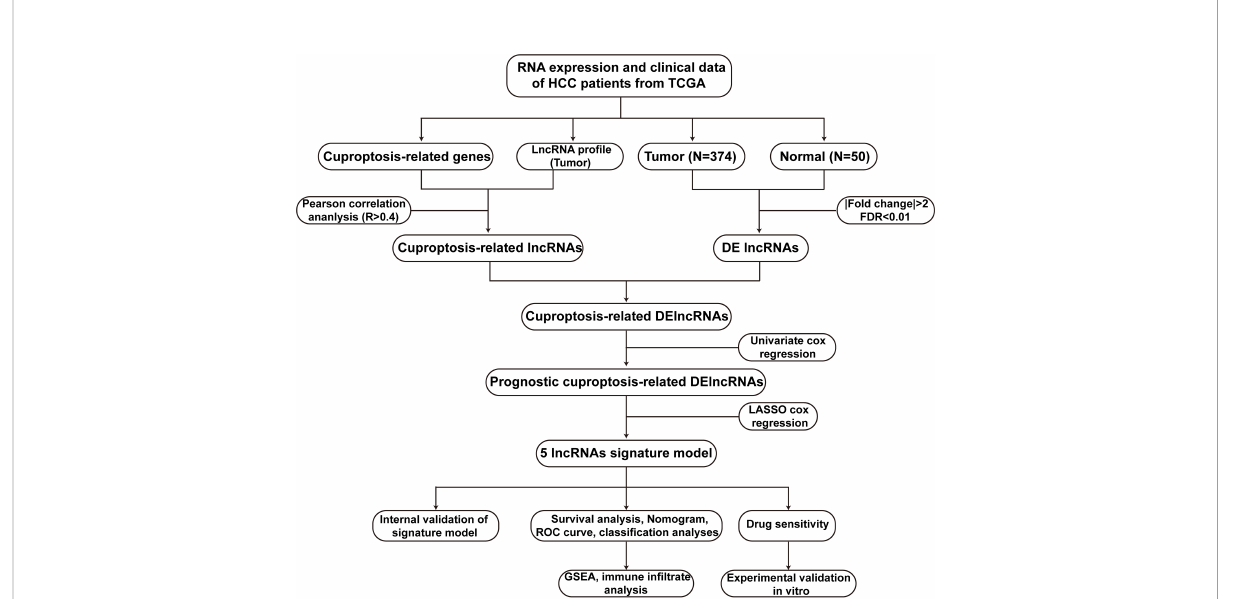
FIGURE 1 The fl owchart of this work. HCC, hepatocellular carcinoma; TCGA, The Cancer Genome Atlas; DElncRNAs, differentially expressed lncRNAs; lncRNAs, long noncoding RNAs; ROC, receiver operating characteristic; GSEA, gene enrichment